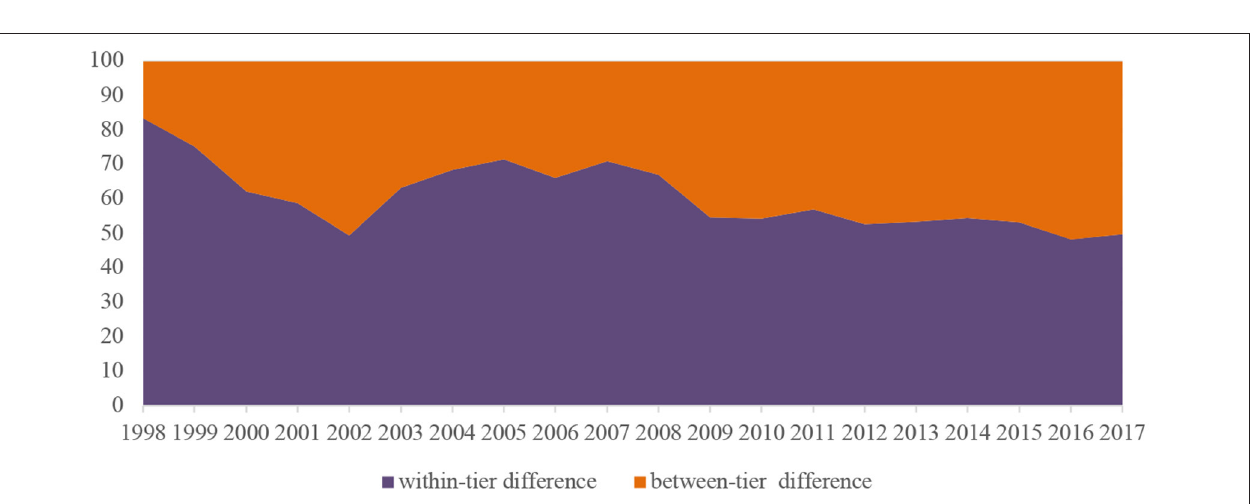
FIGURE 5 | Within-tier and between-tier differences in funding per student among HPIs in